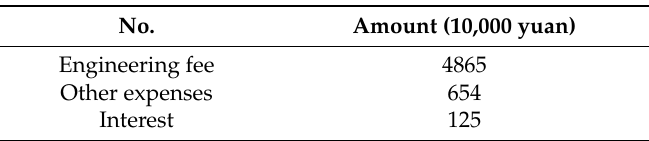
Table 1. System investment estimate.